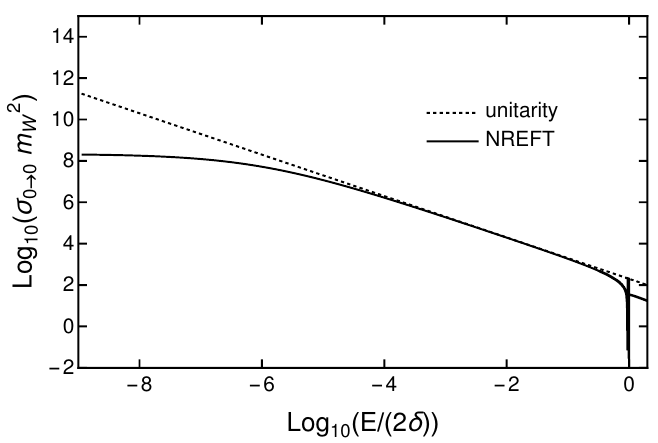
Figure 8 . Log-log plot of the neutral-wino elastic cross section (cid:27) 0 ! 0 ( E ) at the unitarity mass M (cid:3) = 2 : 39 TeV as a function of the energy E . The S-wave unitarity bound is shown as a dotted line.